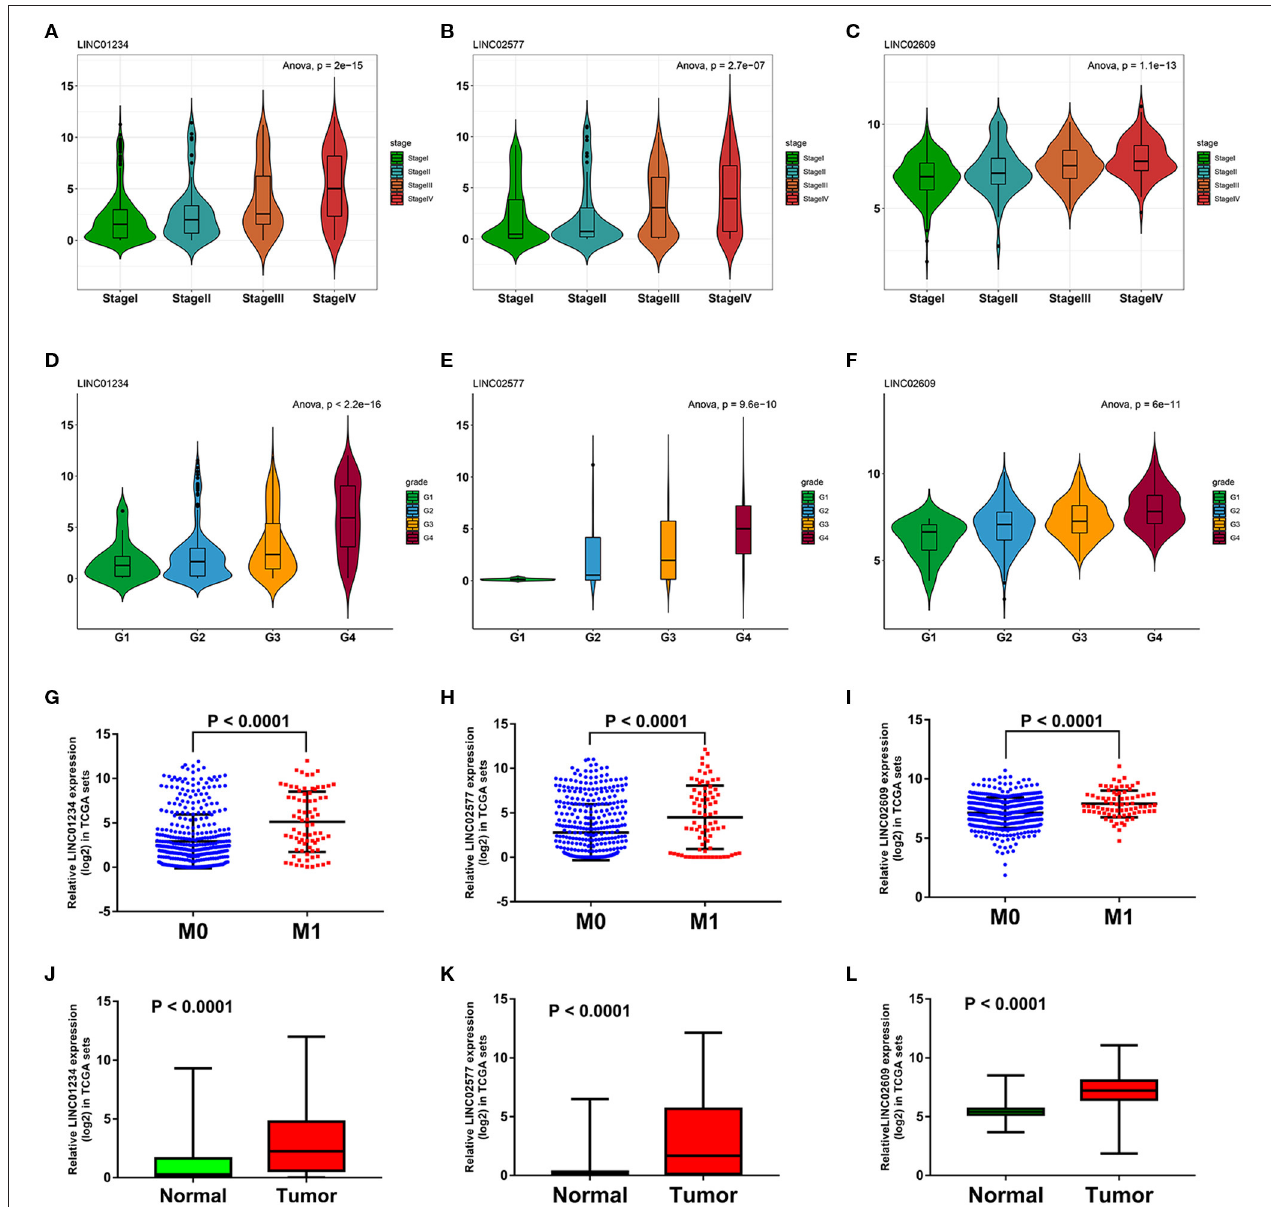
FIGURE 7 | Expression analyses of three key lncRNAs in stage, grade, distant metastasis, normal, and tumor tissues. Expression analyses of LINC01234 (A) , LINC02577 (B) , LINC02609 (C) among different stages. Expression patterns of LINC01234 (D) , LINC02577 (E) , LINC02609 (F) in various grades. Expression analyses of LINC01234 (G) , LINC02577 (H) , LINC02609 (I) between distant metastasis samples (M1) and non-distant metastasis samples (M0). Expression analyses of LINC01234 (J) , LINC02577 (K) , LINC02609 (L) between normal tissues and tumor tissues.The value of p < 0.05 was considered statistically significant. lncRNAs, Long non-coding